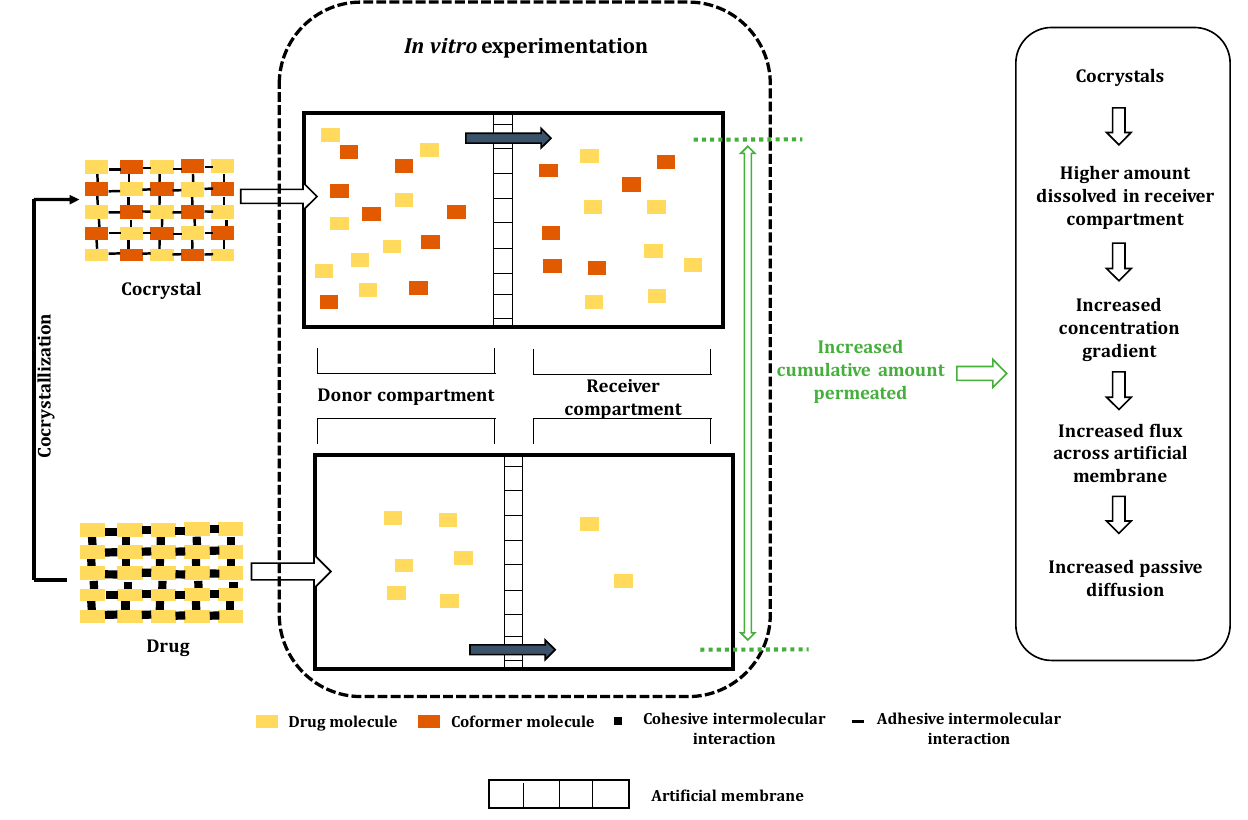
Figure 10. Illustration of enhanced permeability of cocrystals in comparison to pure drug. Table 4. Examples of studies reported on the effects of coformers on the permeability of drug molecules in cocrystals.